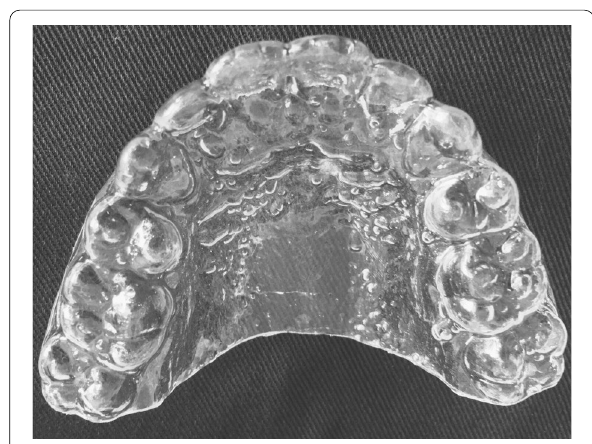
Fig. 1 Hawley retainer used in the trial Fig. 2 Modified vacuum-formed retainer with palatal